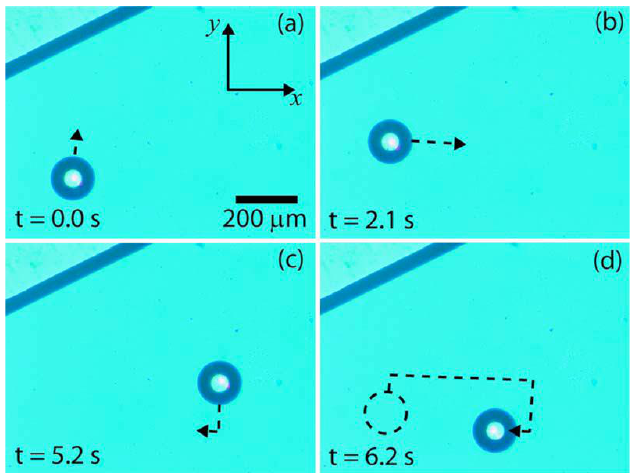
Figure 31. Optically actuated thermocapillary movement of an air bubble in silicone oil. A 114-µm-diameter (1.0 nL) bubble is trapped in the thermal trap created by a laser focused on the absorbing substrate ( a ). The oil/air meniscus can be seen at the top left. The bubble follows the position of the laser spot, as it is scanned in the positive y direction ( b ) and then in the positive × direction ( c ). The bubble is then moved in the negative y and negative x directions ( d ). A dashed circle indicates the initial bubble position, and a dashed line indicates the approximate trajectory of the bubble. Reprinted with permission from